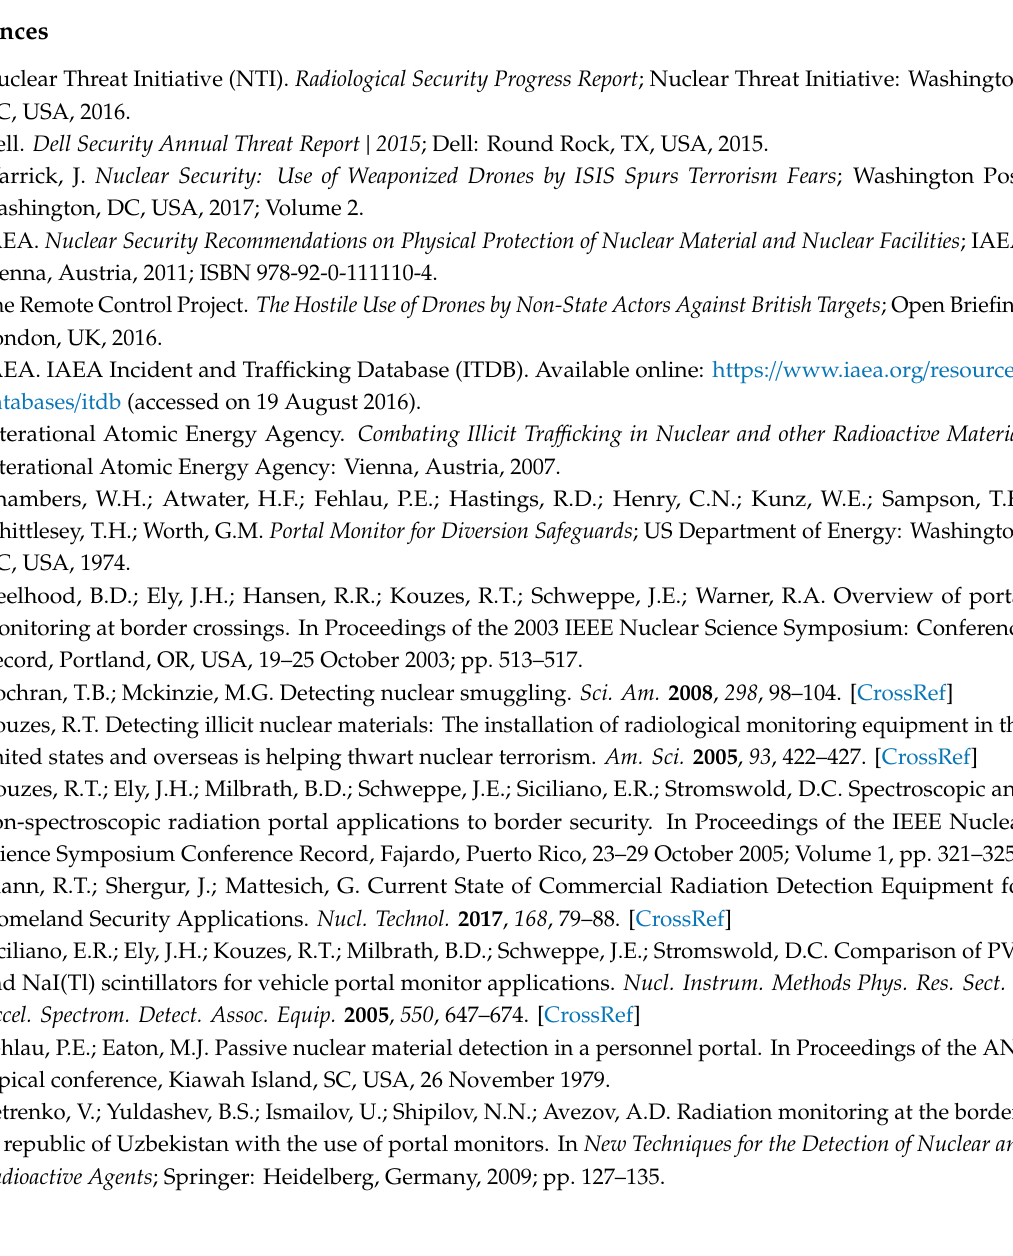
Figure S1: Schematic of the integrated Gate Keeper detection system. Figure S2: Visualisation of the Gate Keeper system validation